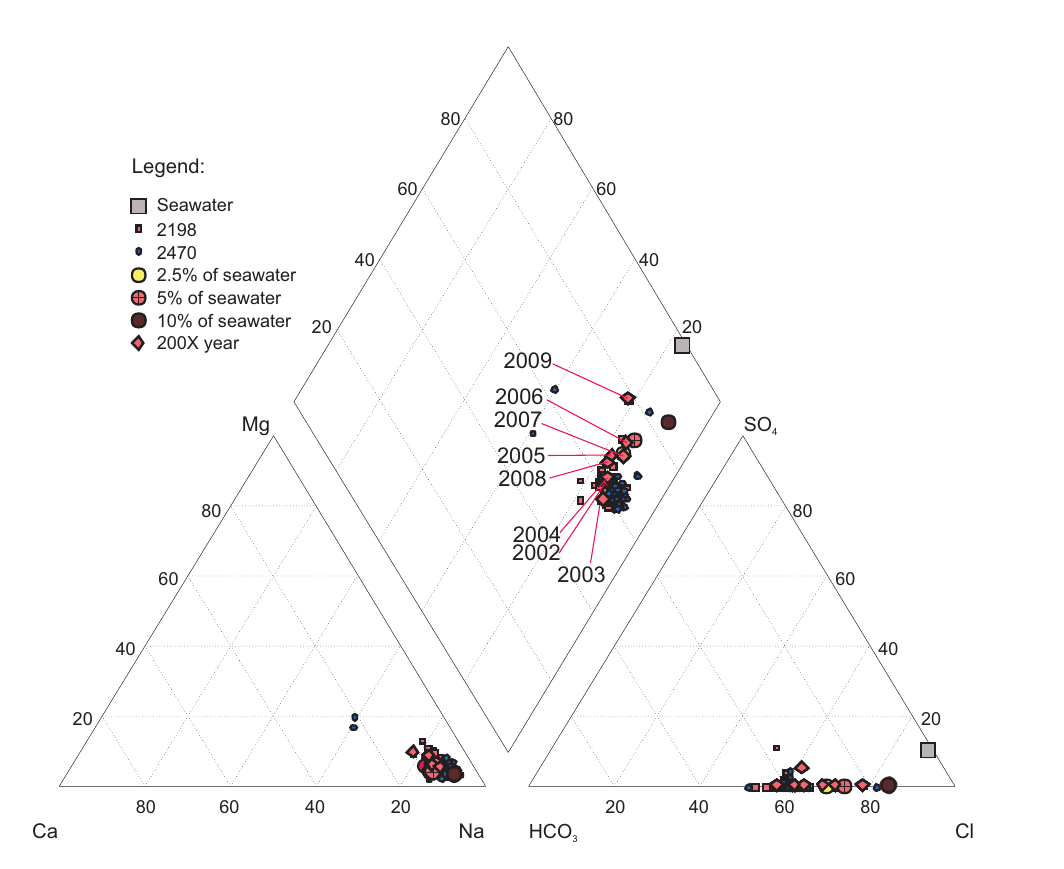
Fig. 8. Changes in water types in well 2198 in recent years.